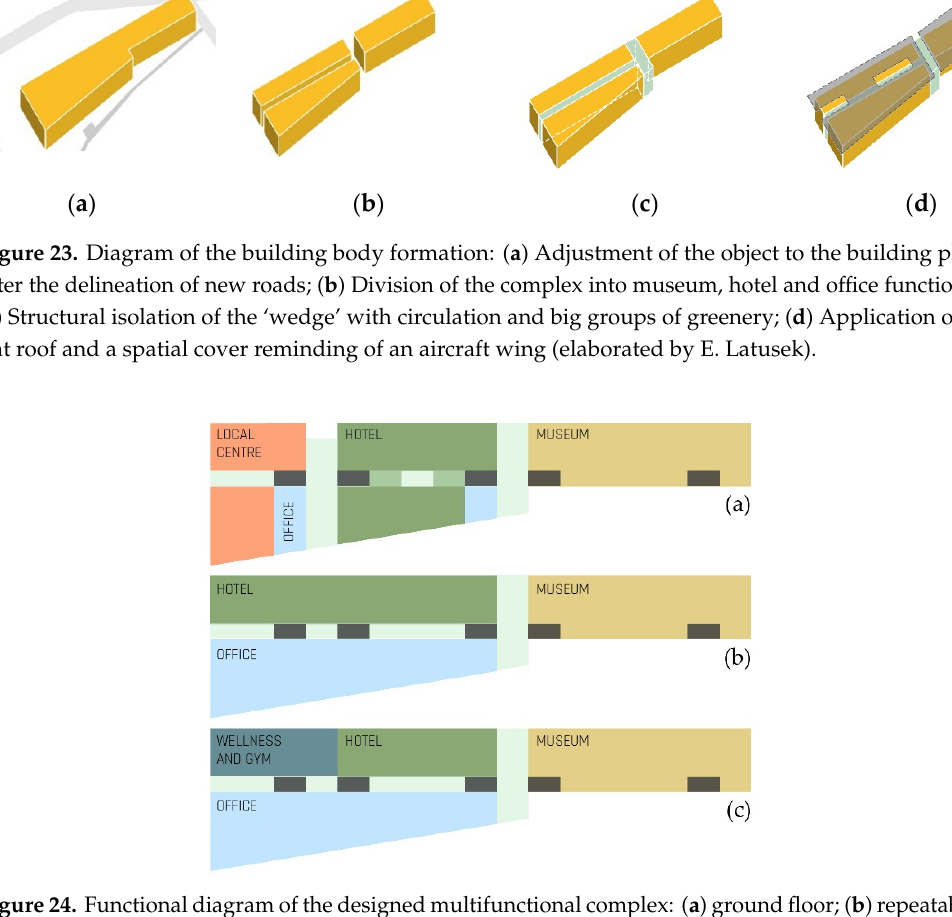
Figure 24. Functional diagram of the designed multifunctional complex: ( a ) ground floor; ( b ) repeatable storeys +1, +2; ( c ) storey +3 (elaborated by E. Latusek).